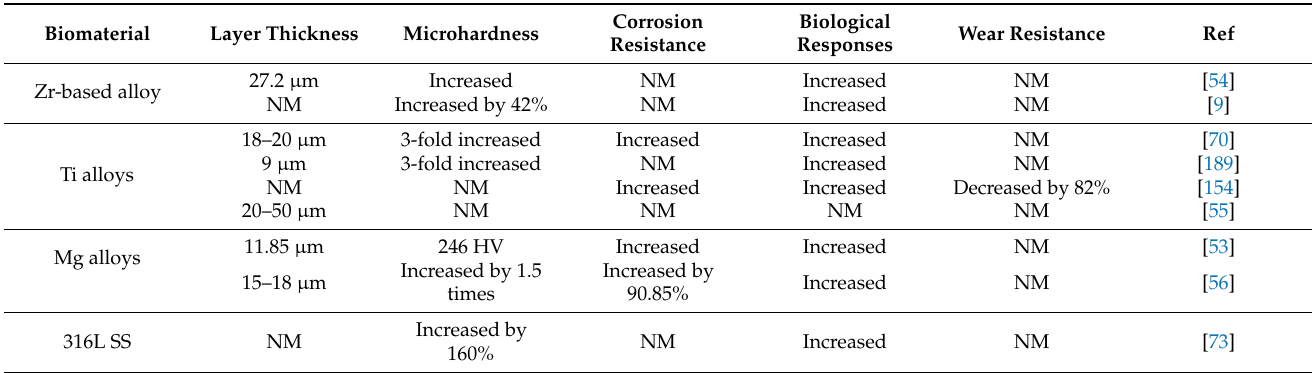
Table 8. Current status of layer thickness, microhardness, and wear and corrosion resistance using the HAp-mixed PM-EDM